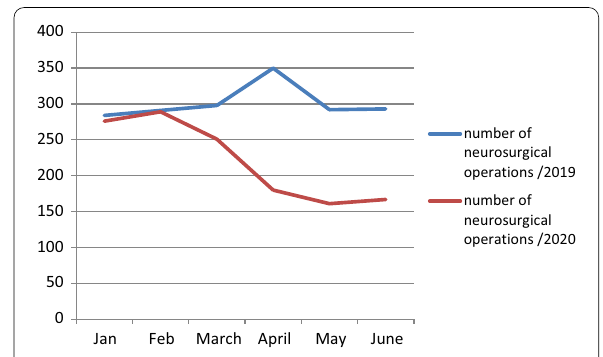
Fig. 1 Number of neurosurgical operations in the 1st 6 months of 2019 and